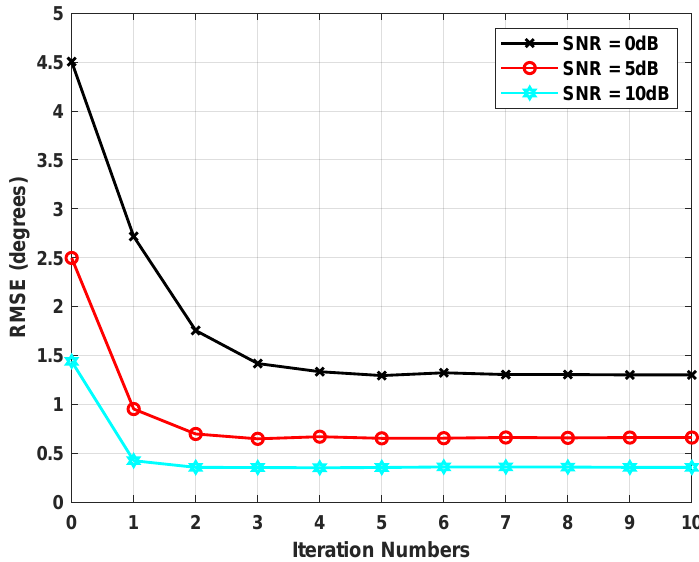
Figure 6. The RMSE of DOA estimation versus the number of